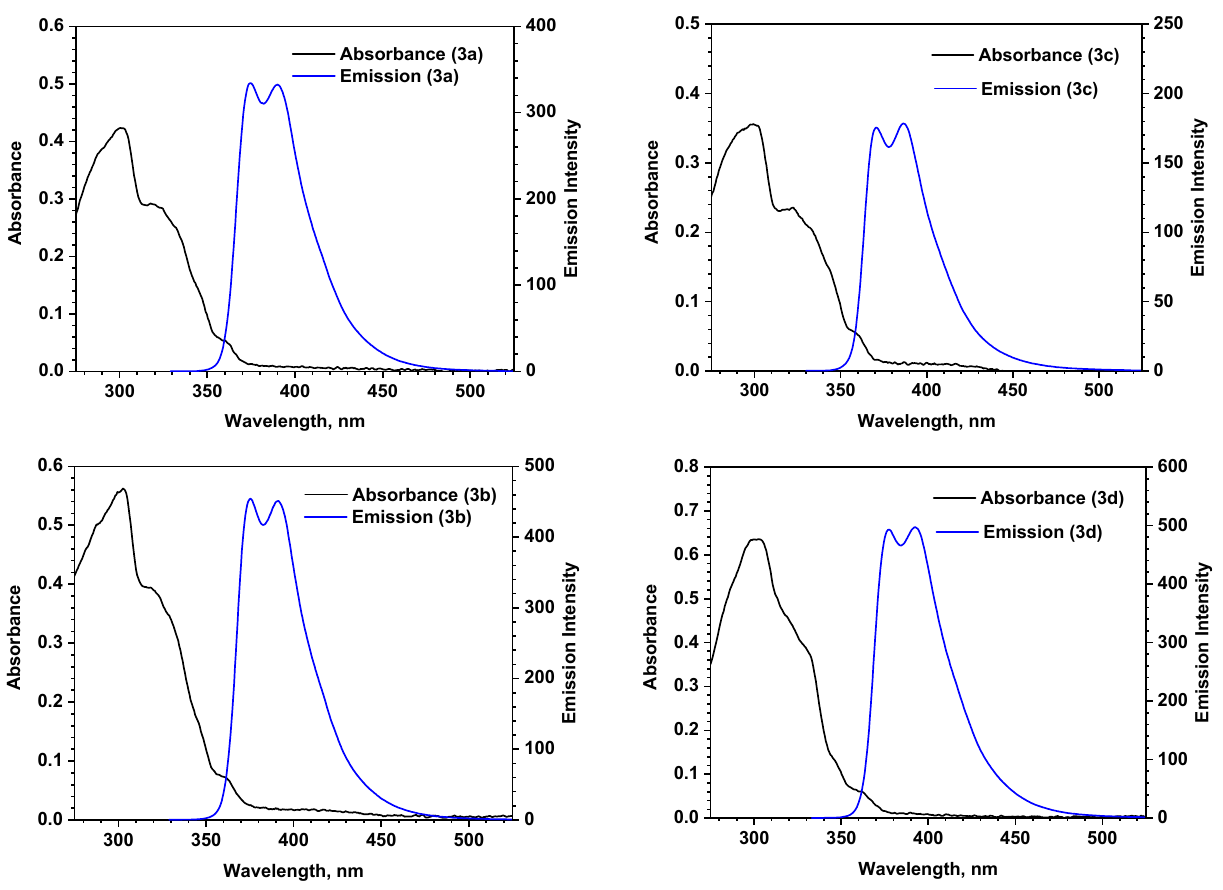
C appears more important in the cation complexation within the calixarene cavity over higher electron density in rings B and D, which are prevented from maximizing their π interactions due to hydrogen bonding at the lower rim.